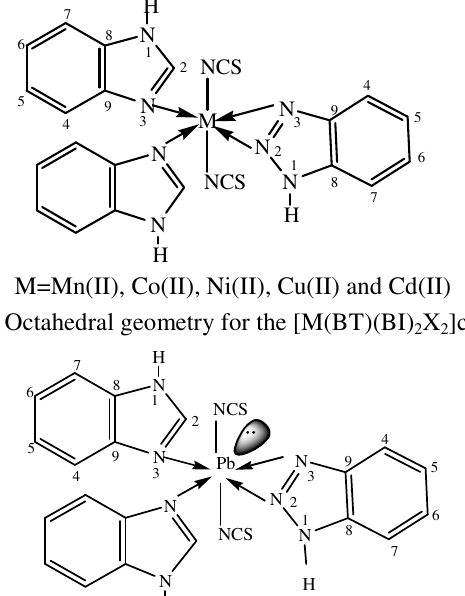
Figure 2. Distorted octahedral for the [Pb(BT)(BI)